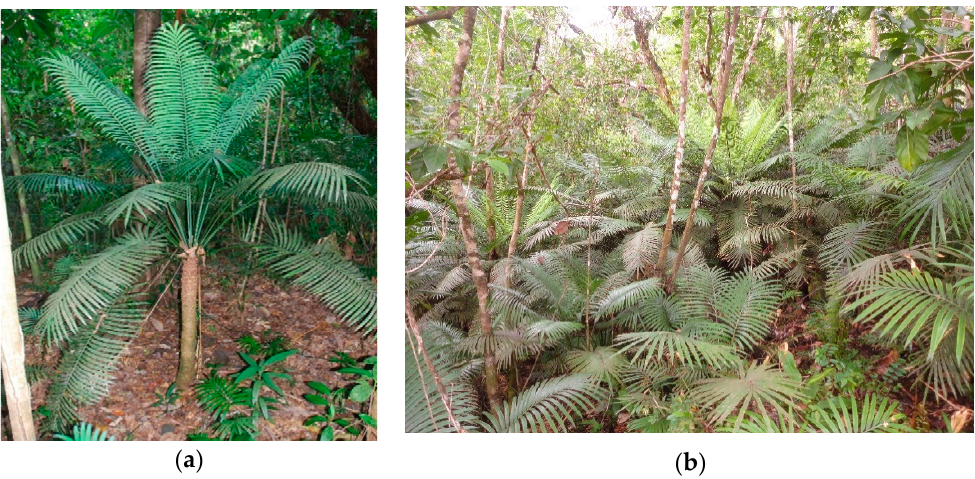
Figure 1. The arborescent Cycas micronesica tree exhibits a pachycaulous stem with radiating large compound leaves. ( a ) Isolated trees reveal the beauty and distinctiveness of this gymnosperm; and, ( b ) Extremely high densities illuminate the role as a foundation species in many of the habitats within its native range.